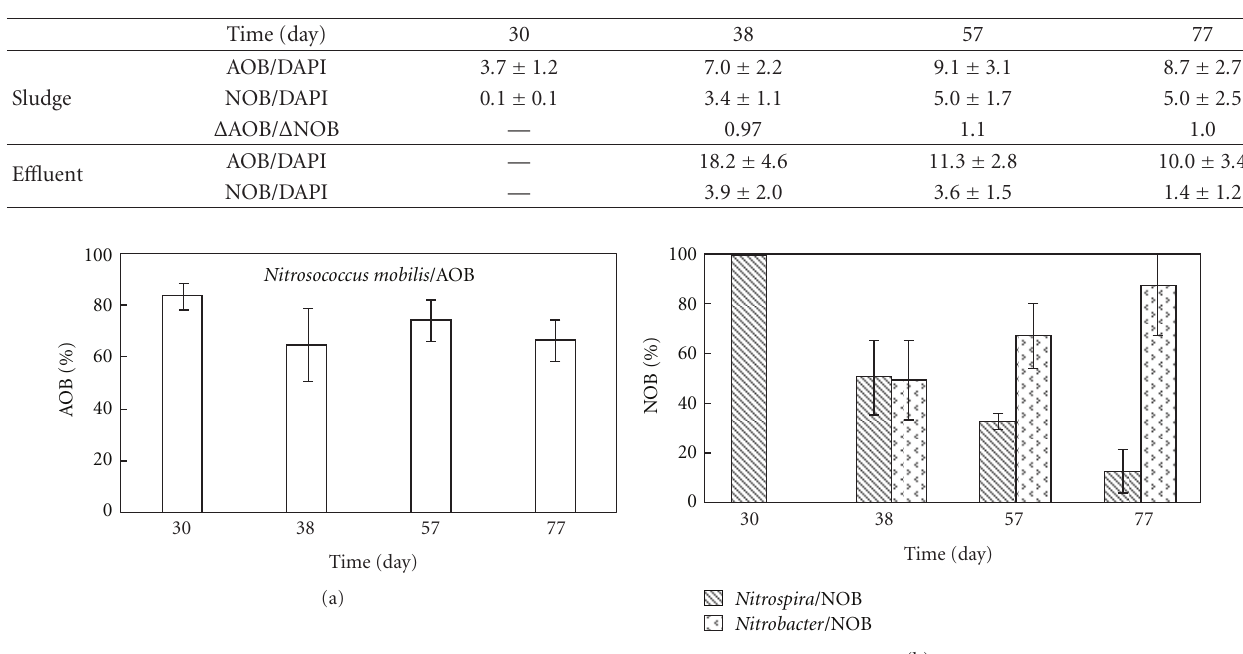
Table 3: AOB and NOB percentages relative to DAPI in the main stream reactor (%).